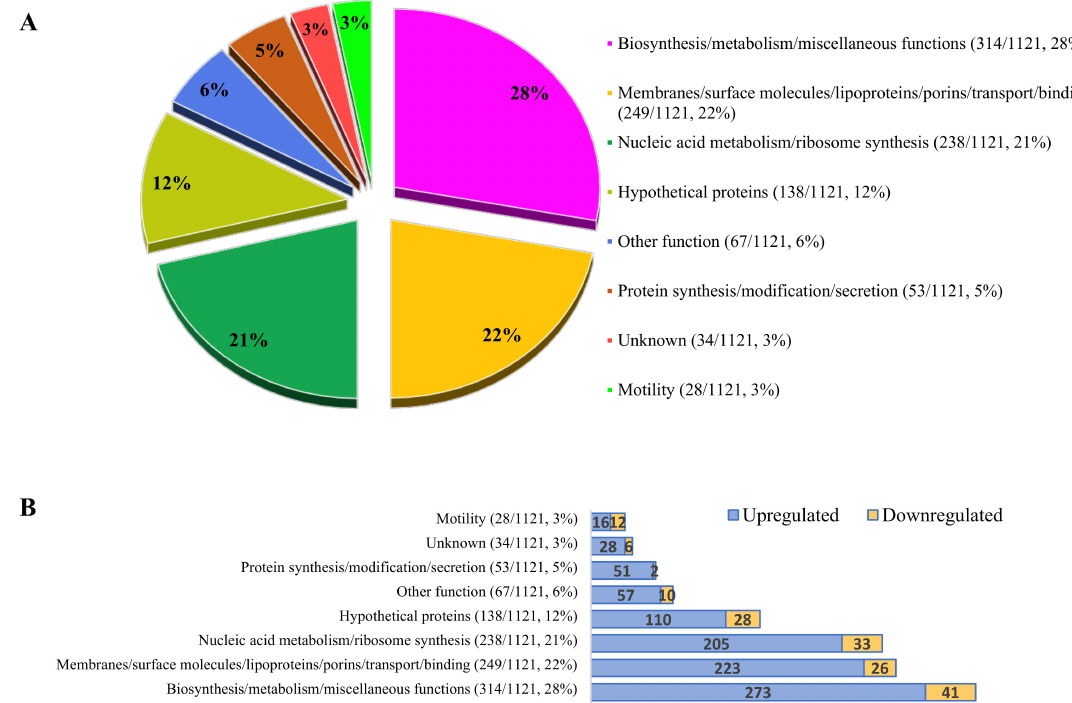
Figure 2. Distribution of the a ff ected functions and genes in the third hour of invasion of the highly invasive strain CjTD-119. ( A ) Ratios of a ff ected major functional groups (chart) and number of genes compared to the whole gene pool (in brackets). ( B ) Distribution of the up- and downregulated genes inside the major functional categories. Genes were assigned to the NCBI gene database. See Supplementary Table S2 for more